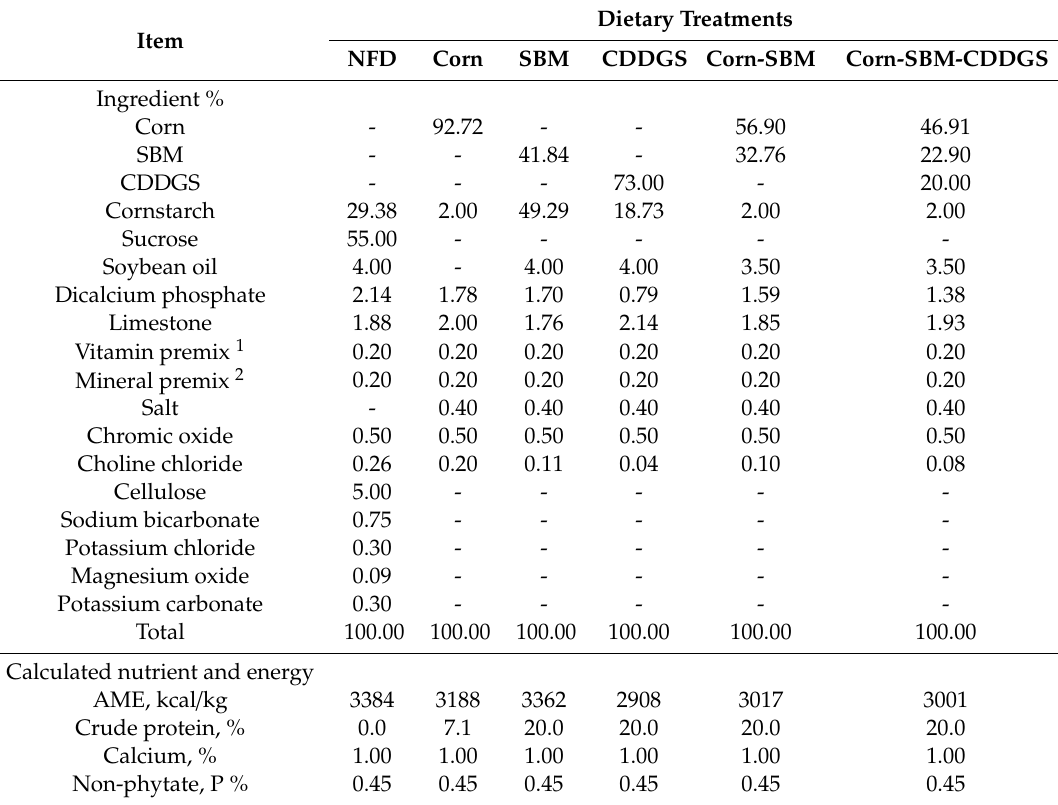
Table 2. Ingredient composition (%) of the experimental diets (as-fed basis).